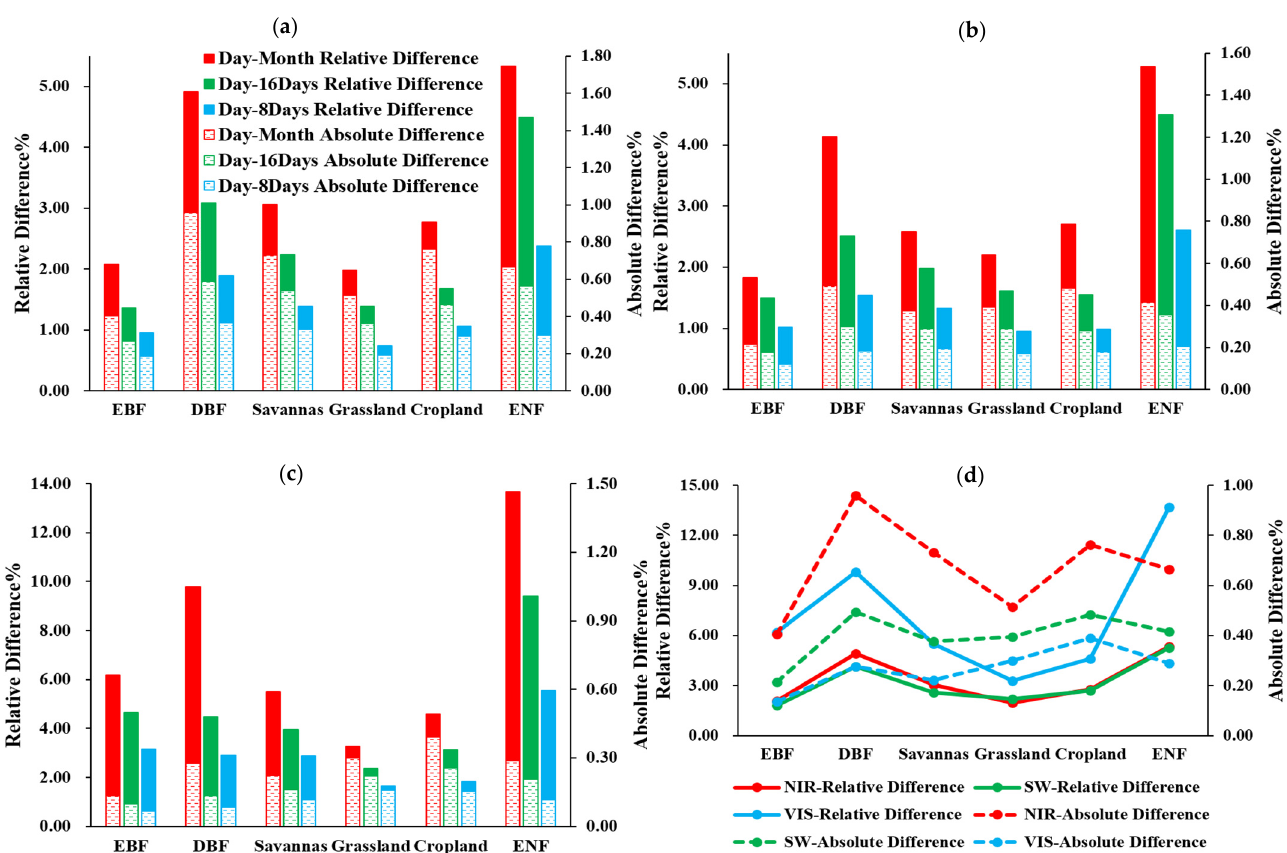
Figure 11. Statistics of albedo differences due to BRDF temporal smoothing in NIR ( a ), SW ( b ), VIS ( c ) and the average monthly albedo differences ( d ) for each study site.